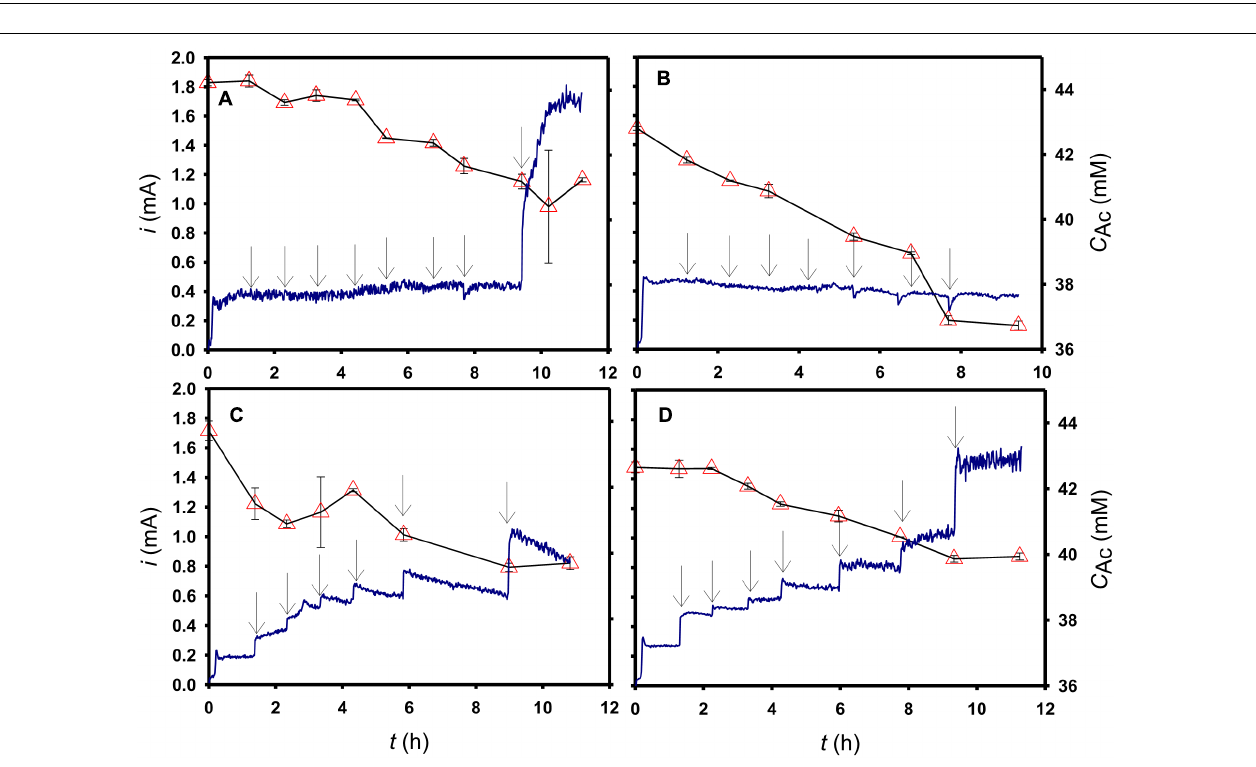
FIGURE 2 | SEM images of S. decolorationis NTOU1 colonizing on the carbon-felt electrodes. (A) the clear structures of piled graphite fibers; (B) developed biofilms of S. decolorationis NTOU1 fed with acetate in the electrochemical cell under the poised potential of + 630 mV.